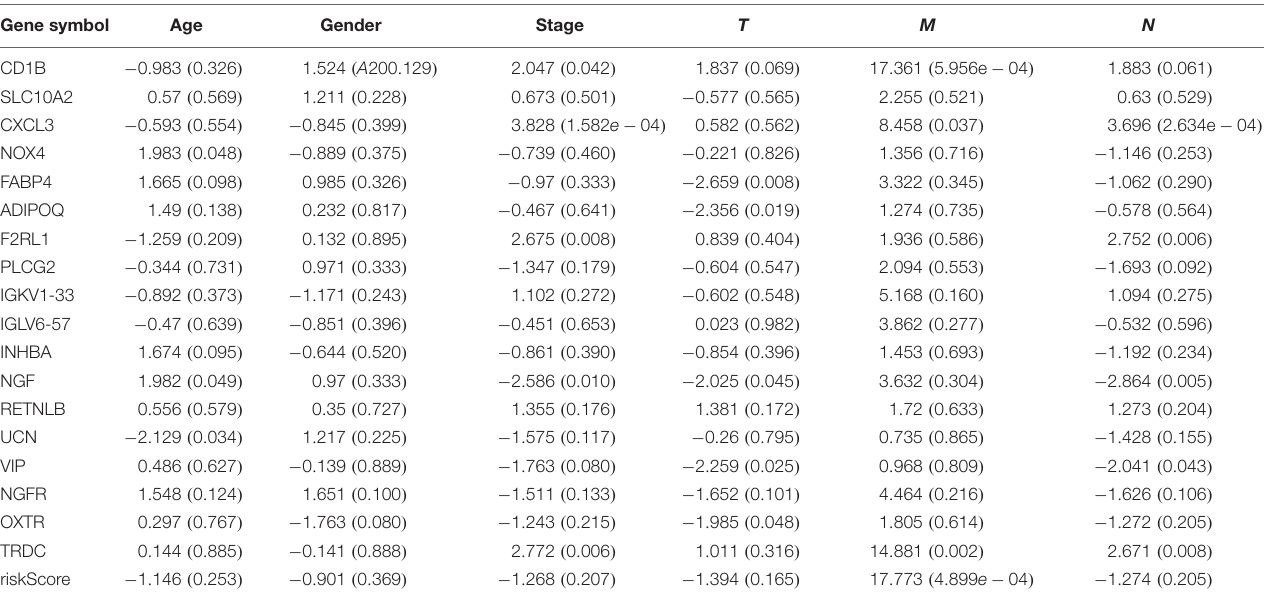
TABLE 6 | Eighteen genes in the risk score model and clinical characteristics correlation